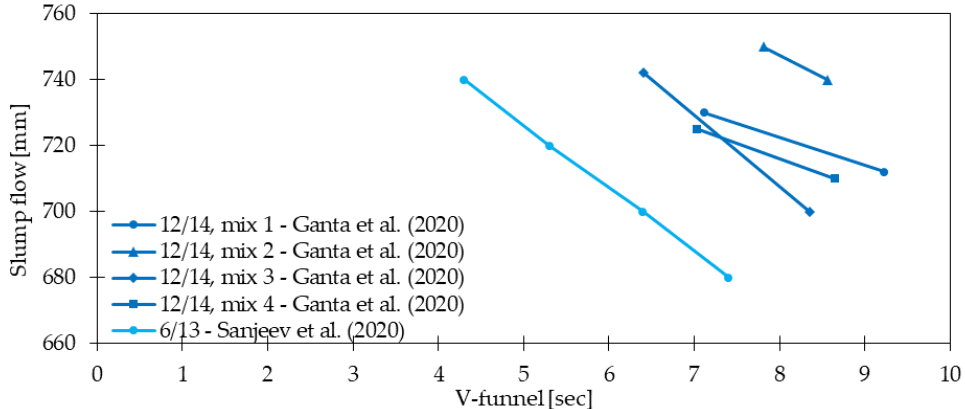
Figure 5. Relationship between V-funnel and slump flow for SCC for different fiber geometry l f /d f [21,36].